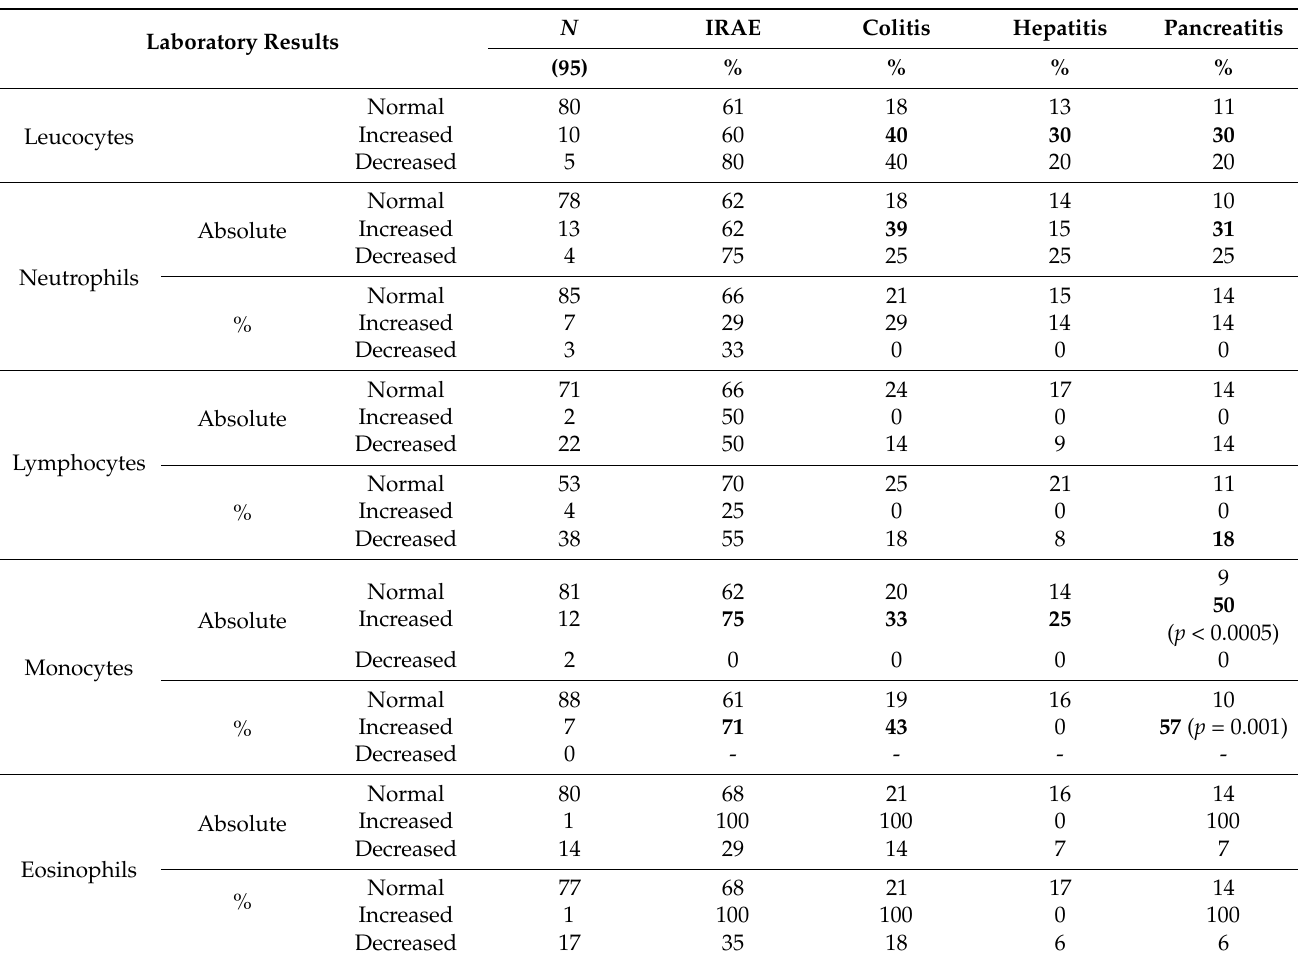
Table 3. Distribution of laboratory results in our cohort in relation to development of IRAE in percent.